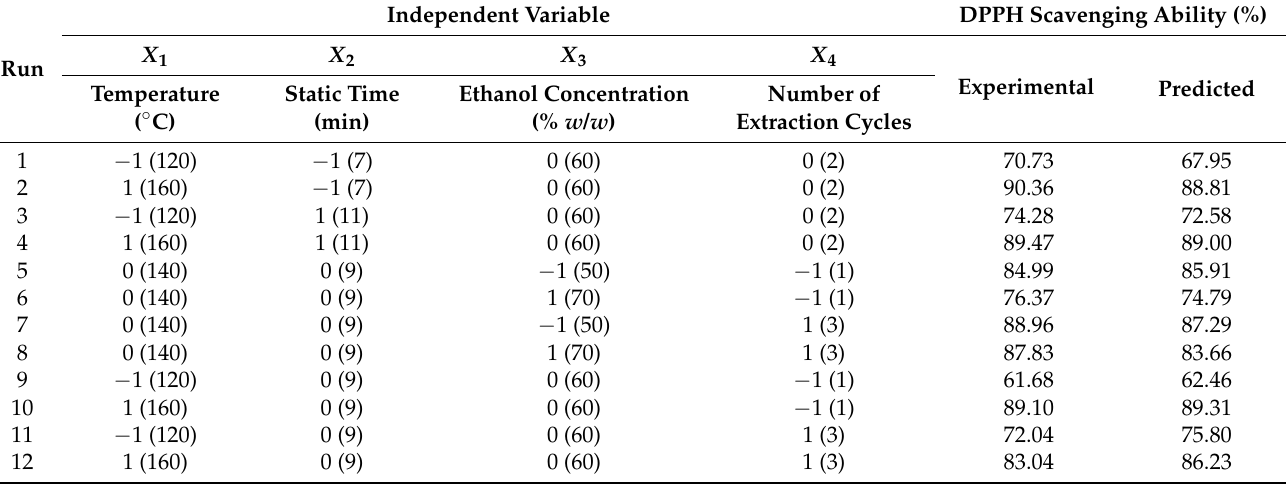
Table 2. Box-Behnken design for optimization of the extraction of antioxidants from Gardeniae fructus by ASE and values of observed